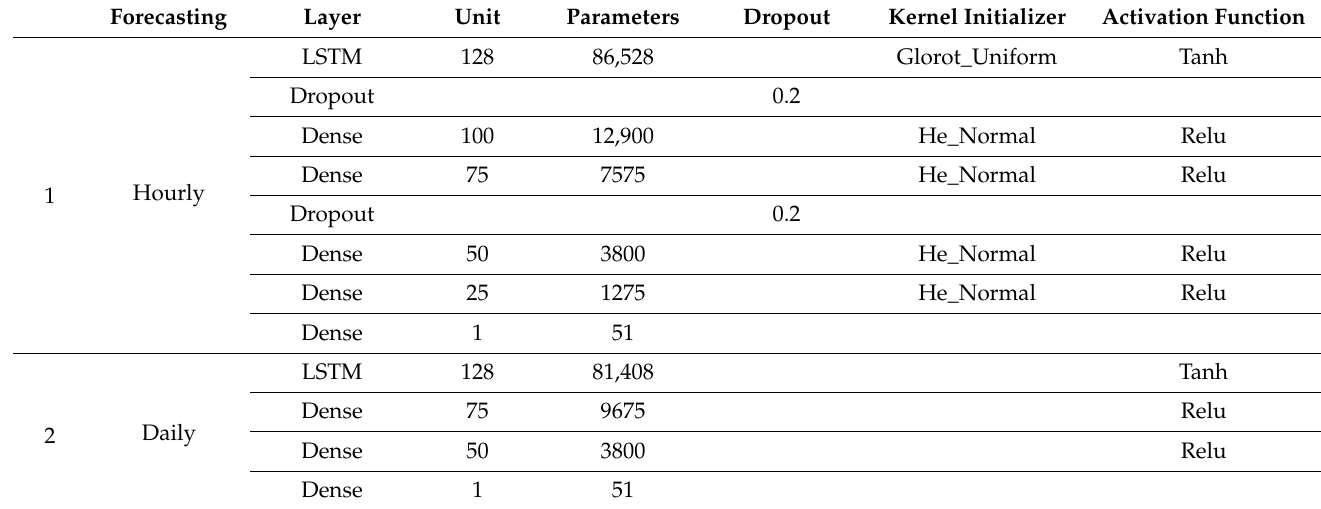
Table 3. The model architecture of the daily and hourly LSTM model.